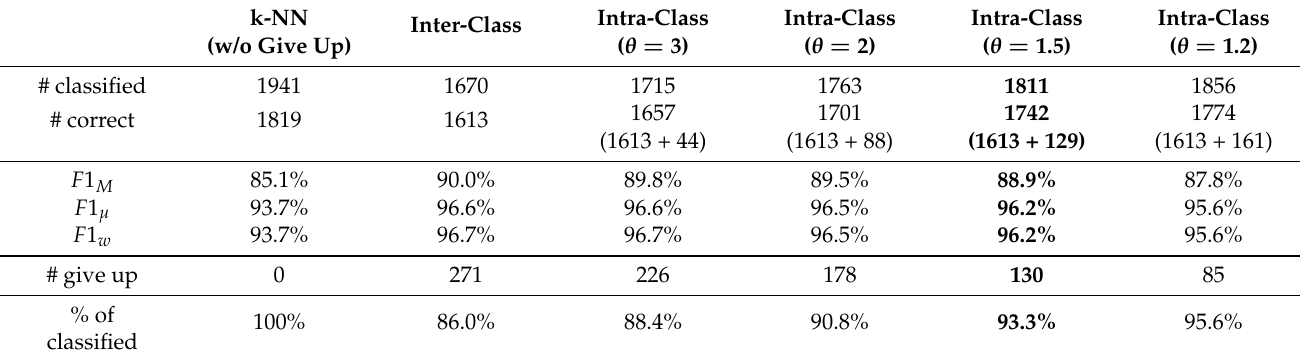
Table 3. Effectiveness of inter-close and intra-close closeness. The accuracy and postponing rate are balanced when θ = 1.5 .